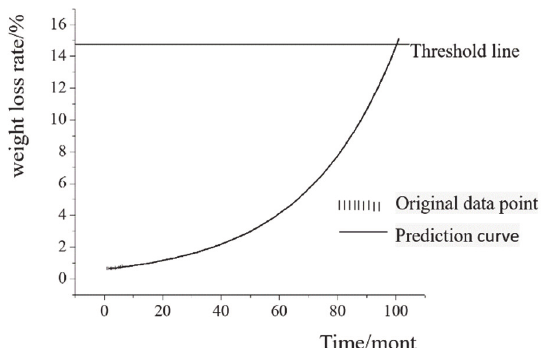
Figure 2: The Prediction curve and original data point at close and damp environment.